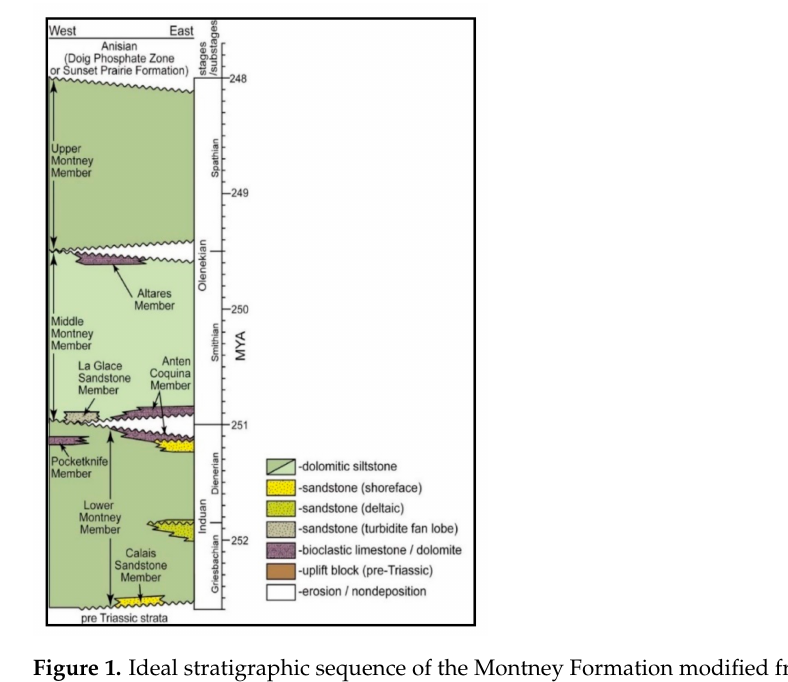
Figure 1. Ideal stratigraphic sequence of the Montney Formation modified from [37].